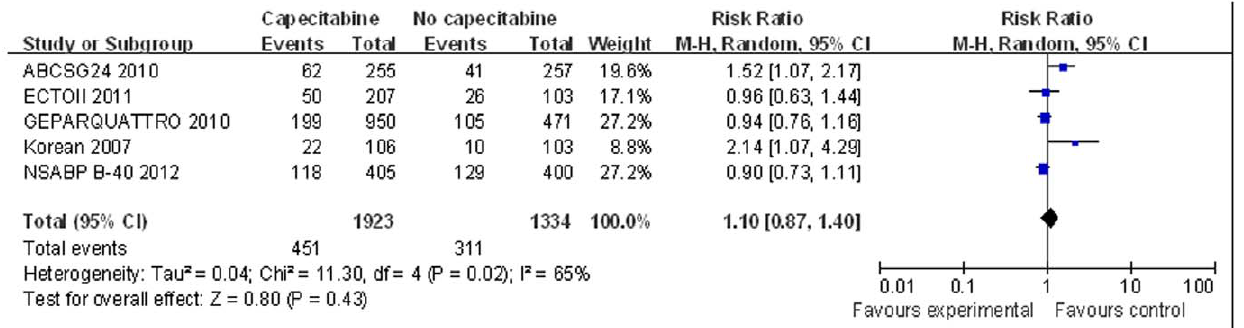
Figure 2. Forest plot to meta-analyze pCR outcomes for neoadjuvant therapy with or without capecitabine.